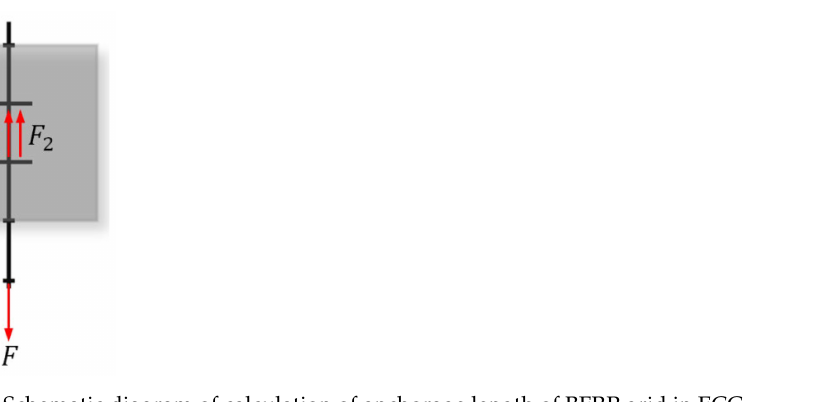
Figure 6. Schematic diagram of calculation of anchorage length of BFRP grid in